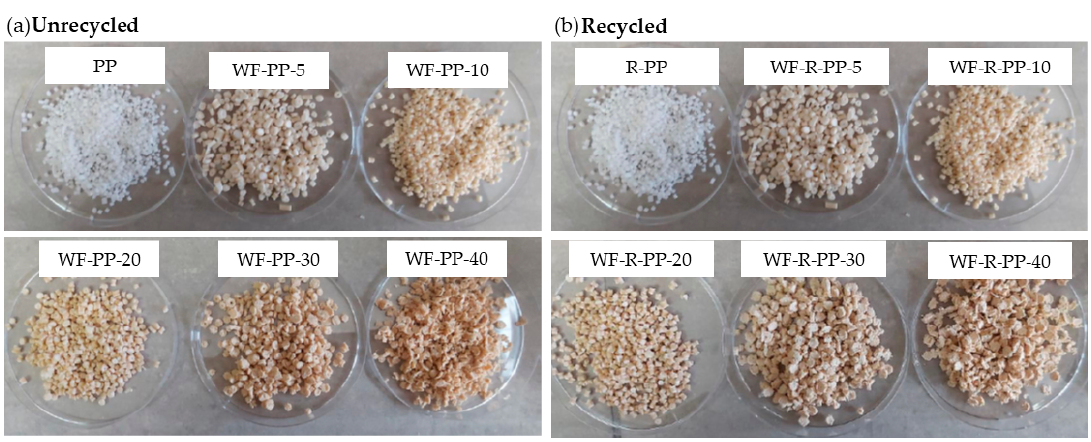
Figure 1. Granulated materials with different wt.% of wood fiber (WF) for unrecycled ( a ) and recycled ( b ) composite materials.